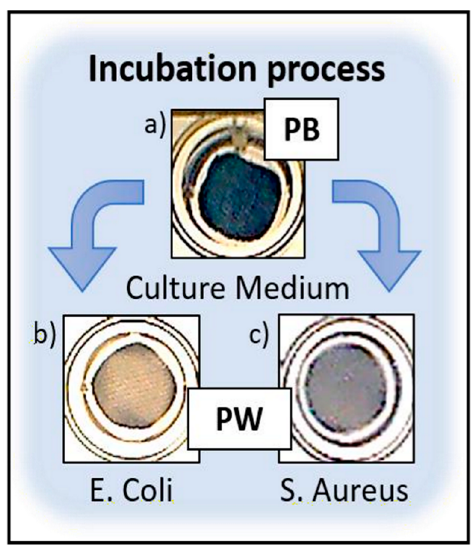
Figure 4. ( a ) PB modified fabrics in culture medium. ( b ) Modified samples after 24 h of incubation with E. coli (5.7 × 10 10 CFU/mL) and ( c ) S. aureus (5.9 × 10 10 CFU/mL).